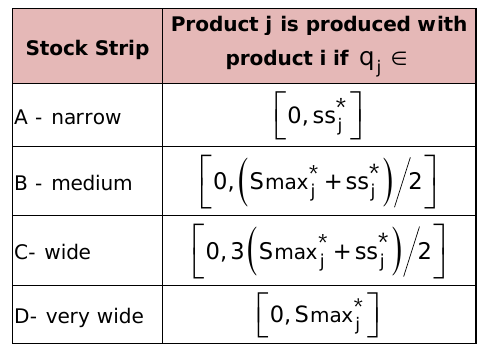
Table 2. “Definition of Stock